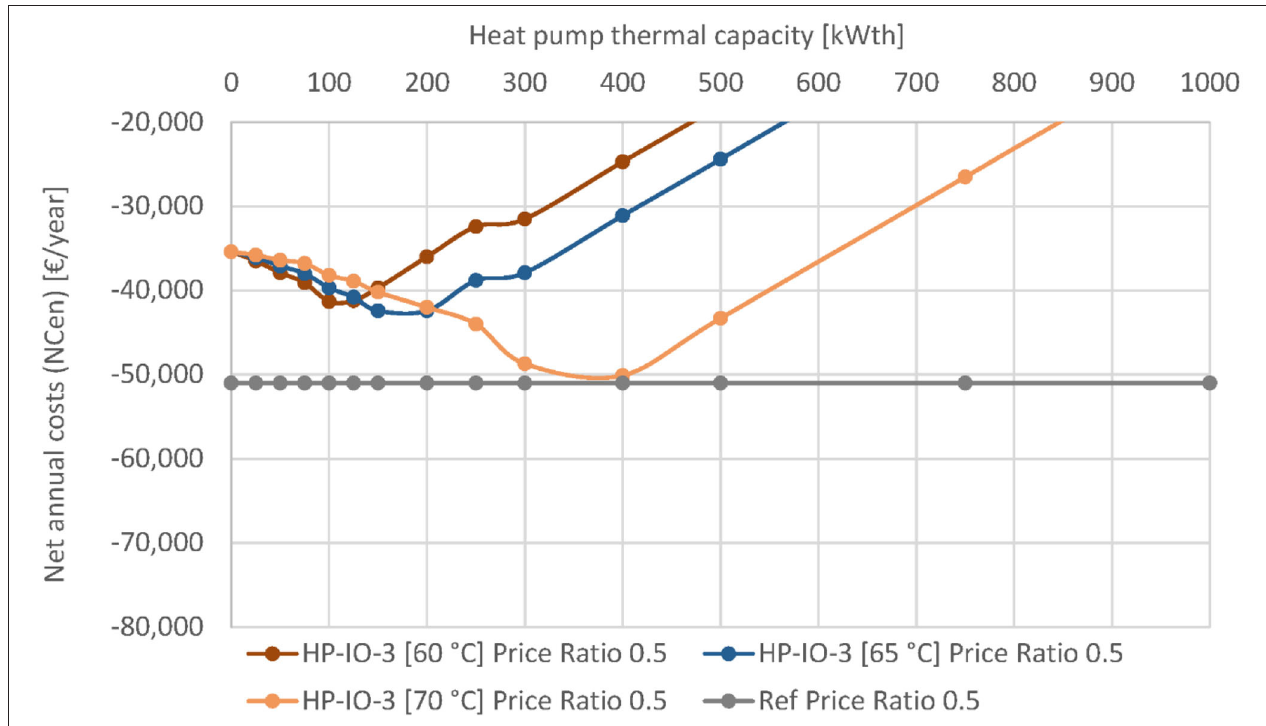
FIGURE 7 | Net annual costs ( NC En ) of HP-IO-3 at three different flow temperatures at price ratio 0.5. Negative net annual costs are net annual